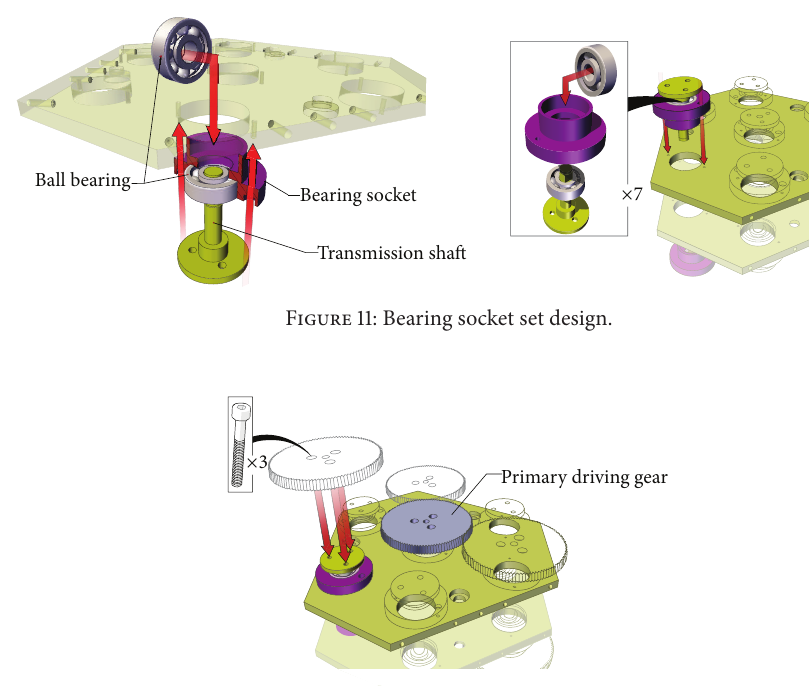
Figure 12: Geared powers source design.